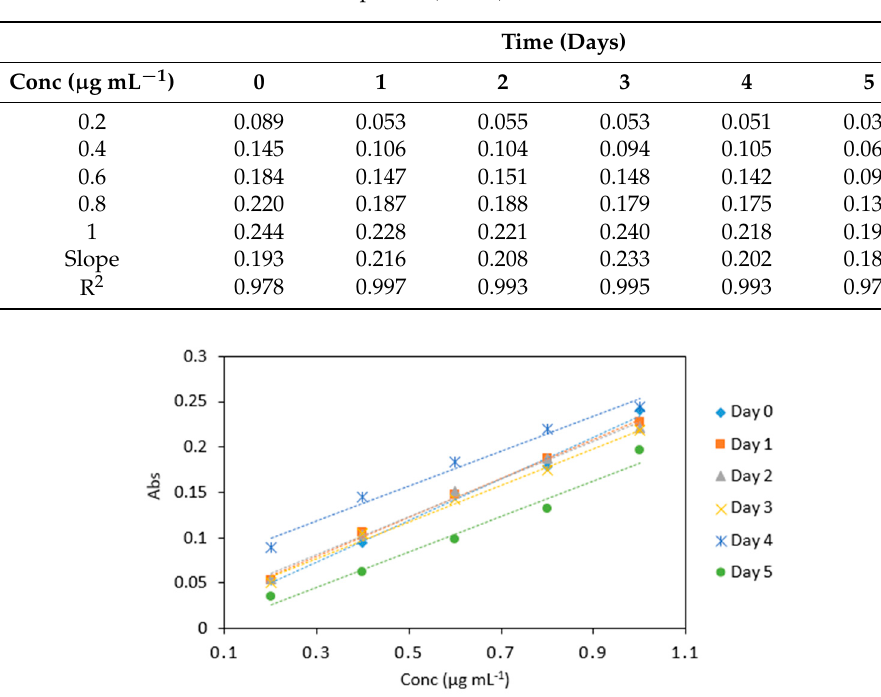
Figure 8. Stability of potassium iodate and hydrochloric acid mix in arsenic samples (0.2–1 μ g mL − 1 ) analyzed periodically over day 0, 1, 2, 3, 4, and 5. All measurements were carried out in triplicate ( n = 90).